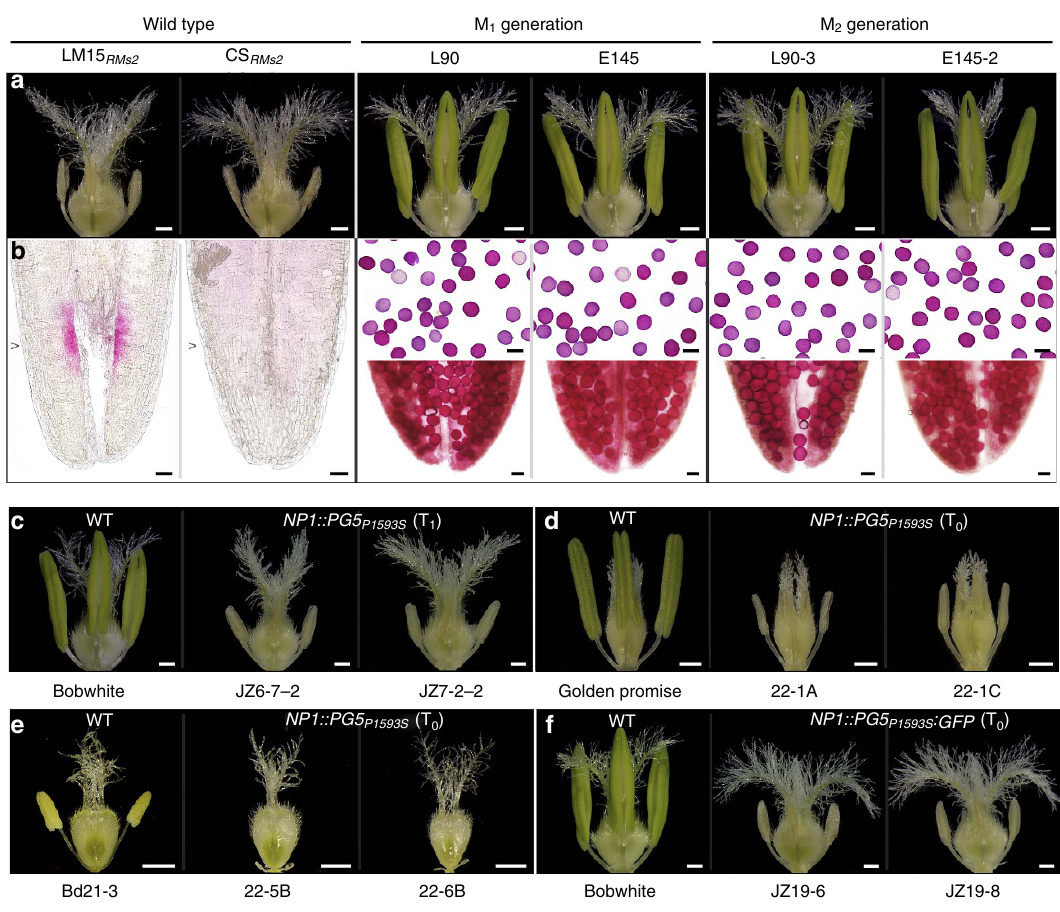
Figure 3 | PG5 P1593S confers male-sterility in Taigu. ( a ) Mature flowers from LM15 RMs2 and CS RMs2 with diminutive anthers, and CS RMs2 mutants with normally-sized anthers. ( b ) Alexander’s staining of anthers (lower) and pollen (upper, except when no pollen was produced). Wheat lines are the same as in ( a ). ( c – f ) Flowers in wild-type (WT, on left) and transgenic wheat ( c , f ), barley ( d ) and Brachypodium ( e ). Male-sterile transgenic plants at the T 1 ( c ) and T 0 ( d – f ) generations were positive for the native PG5 P1593S gene (PC976; c – e ) and the PG5 P1593S :GFP gene (PC973; f ). Scale bars, 500 m m ( a , c – f ) and 50 m m ( b